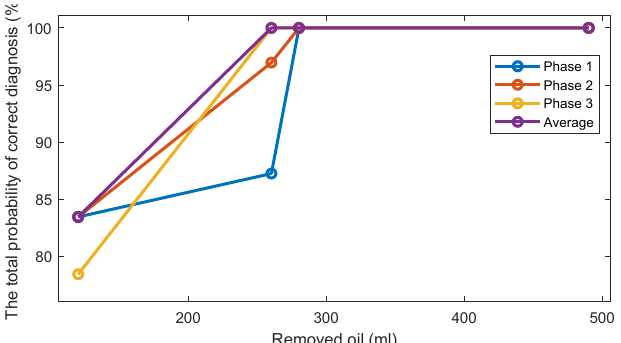
Figure 11. The estimates of the TPOCD, provided by technology 2 for three phases and 4 levels of oil removal compared to the standard oil level (Day 1).